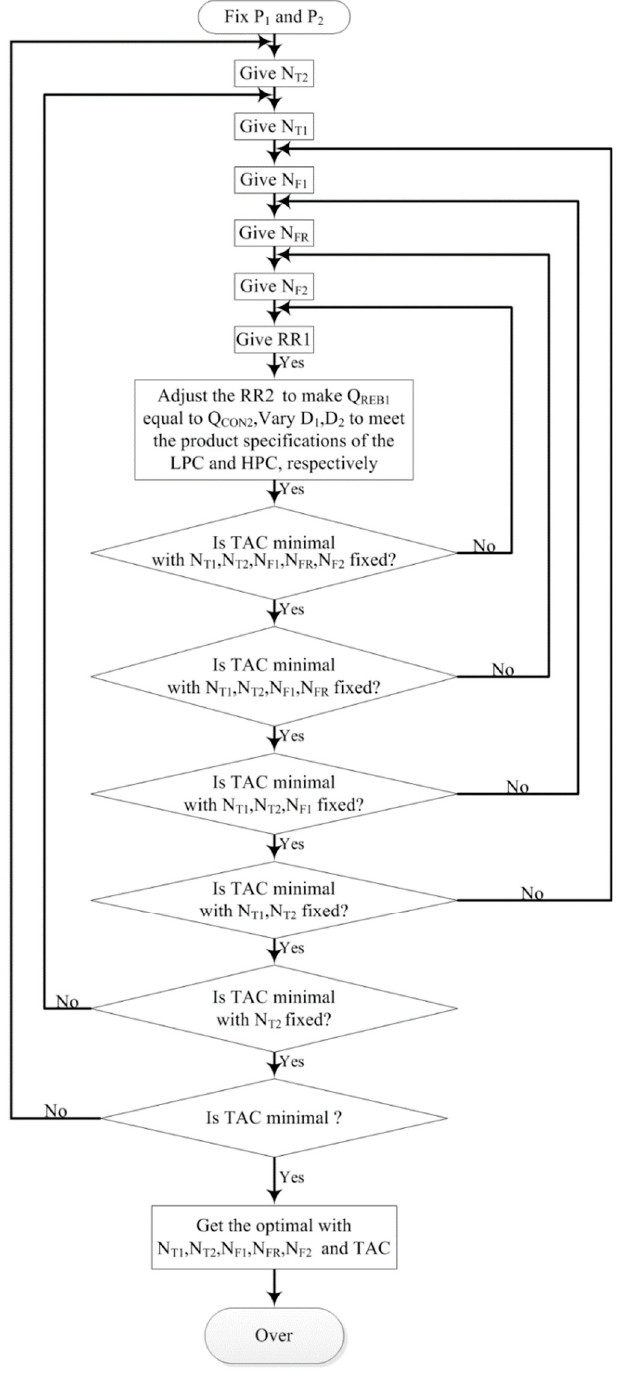
Figure 4. Optimization sequence of acetonitrile–water separation process by pressure swing distillation (PSD) with full-heat integration.